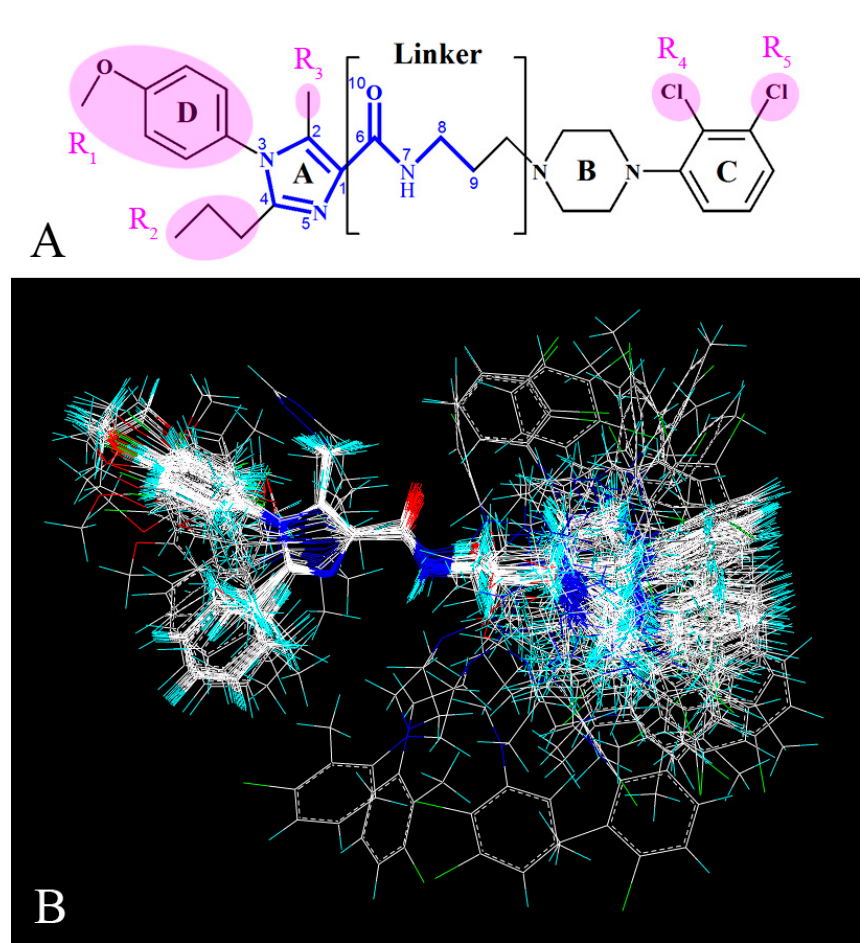
Figure 1. Molecular alignments of all compounds in the data set. ( A ) The common structure of molecules based on template compound 13 is displayed in bold; ( B ) The resultant alignment model.